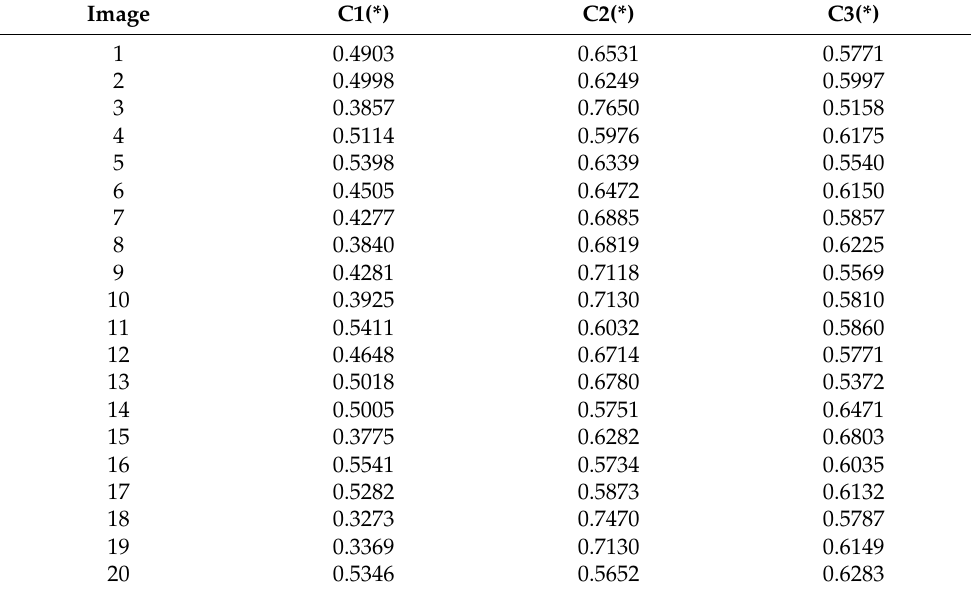
and blue bands of the RGB image computed by the illumpca function.